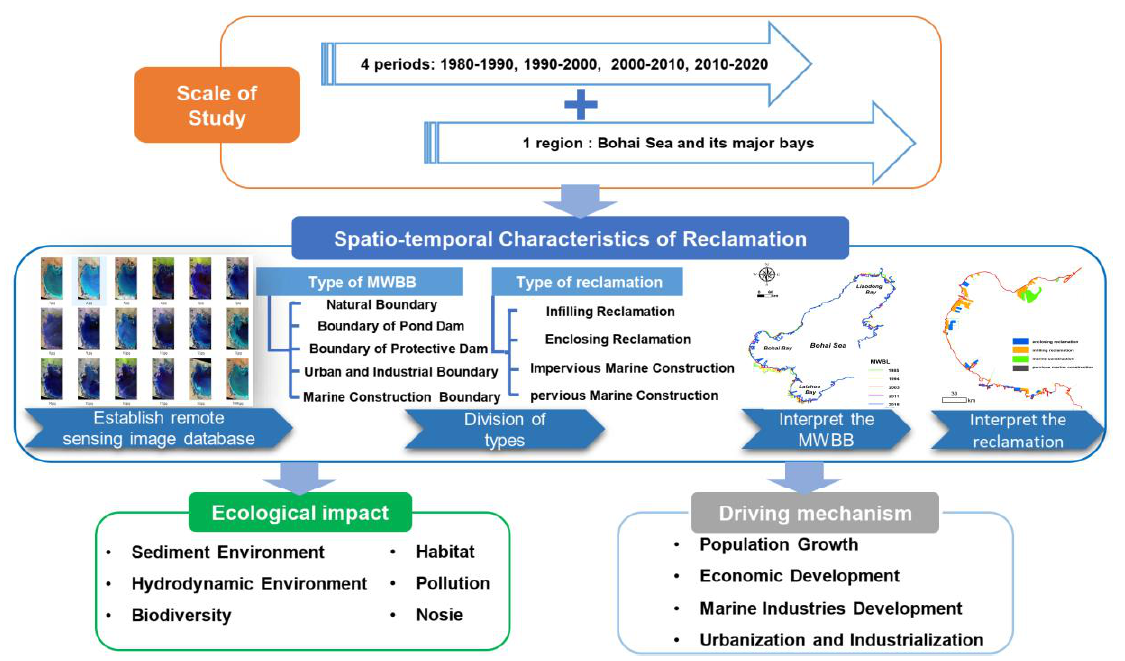
Figure 1. Conceptual framework of study.